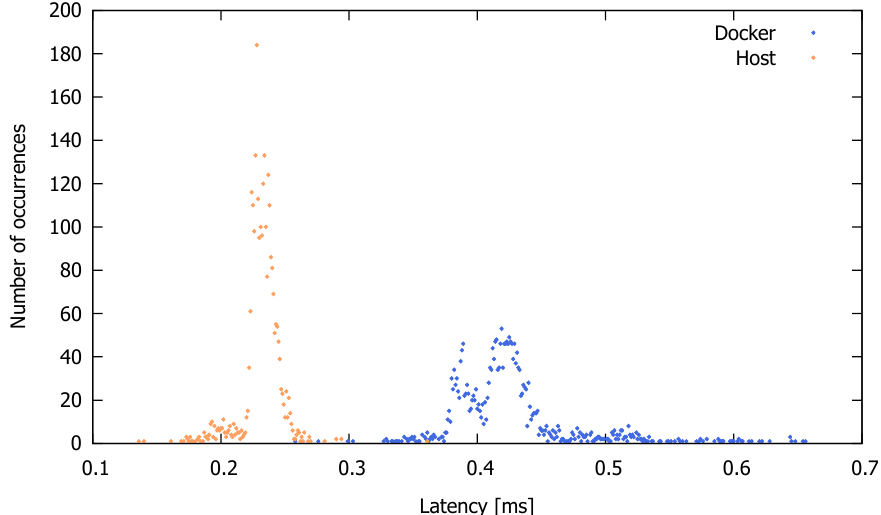
Figure 19. Communication latency between nodes for Docker and